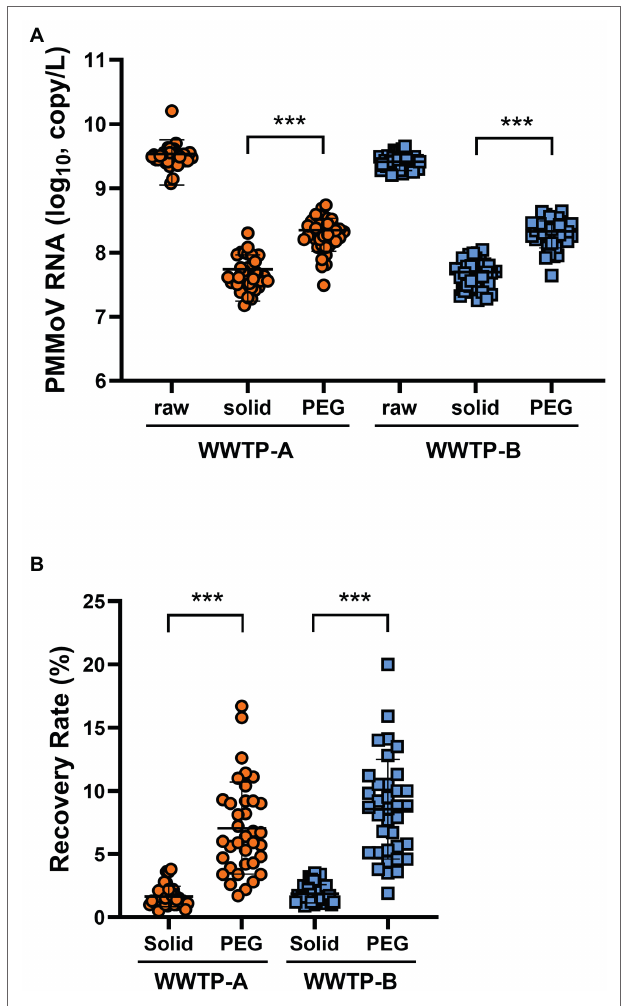
FIGURE 1 | Quantification of pepper mild mottle virus (PMMoV) RNA. (A) RNA samples from wastewater treatment plant (WWTP)-A (orange circles) and WWTP-B (blue squares) were quantified for PMMoV RNA copy number via RT-qPCR. (B) Recovery rate (%) of concentrated samples calculated from PMMoV RNA copy number. Raw: unconcentrated raw wastewater; solid: solid fraction; PEG: PEG-precipitated fraction. Bars indicate the mean ± SD ( n = 36). Statistical significance was calculated using the Mann–Whitney U test. *** p < 0.001.